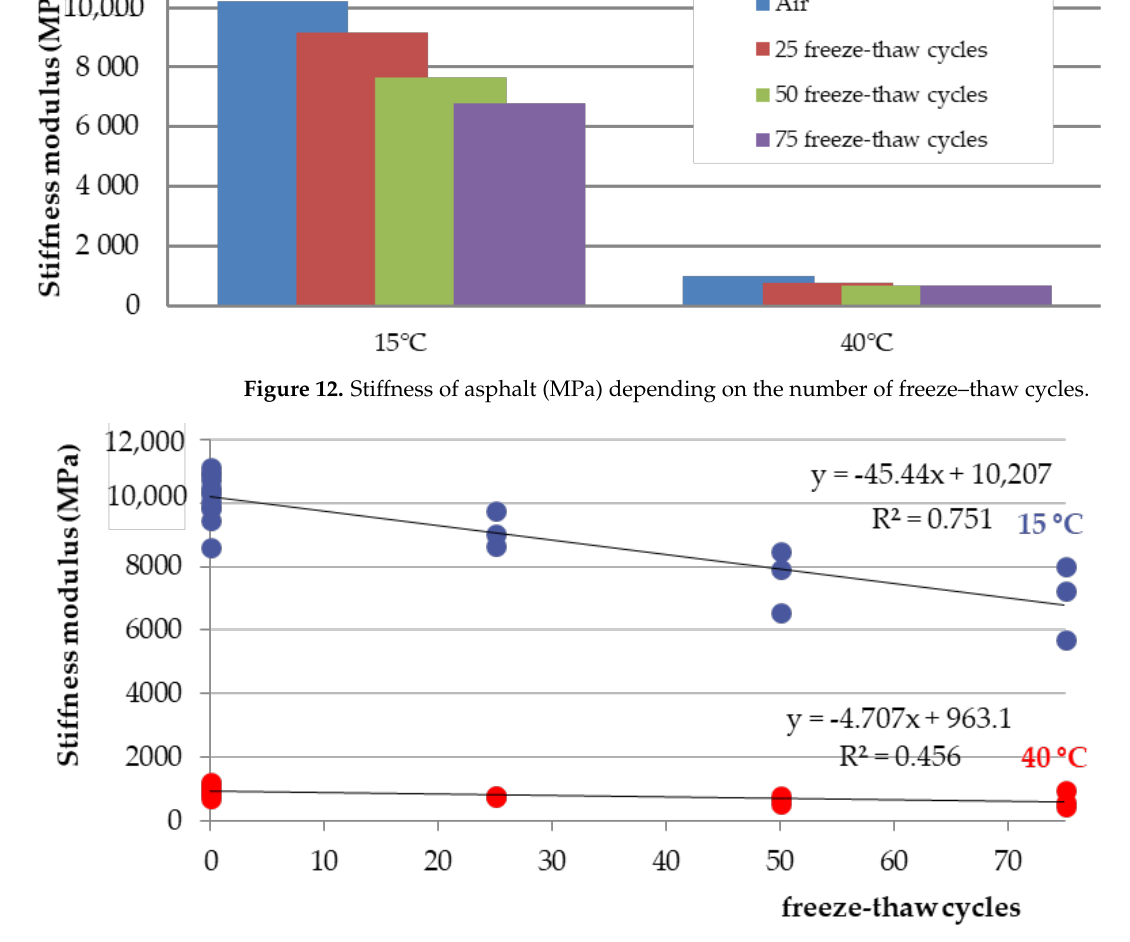
Figure 13. Relationship between stiffness modulus at the test temperatures of 15 °C and 40 °C and the number of freeze – thaw cycles.